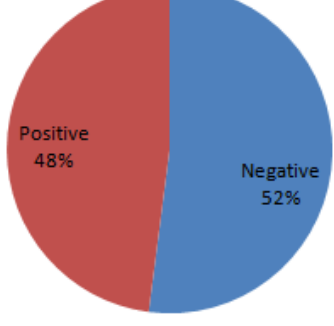
Figure 6. Principle of integration.